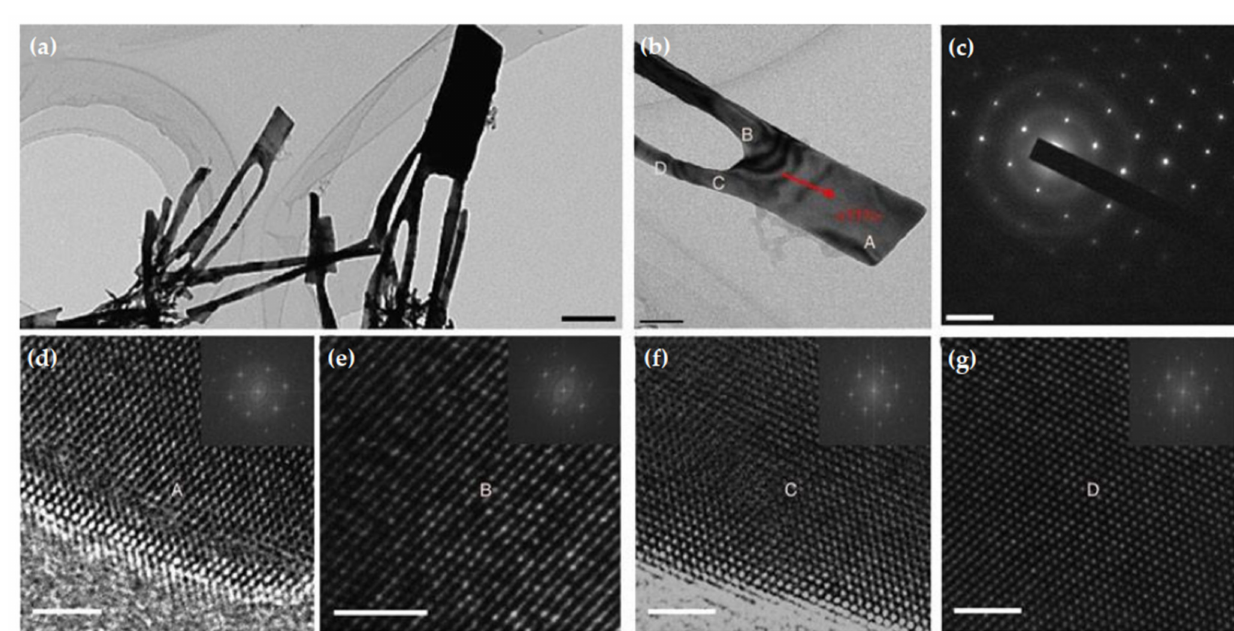
Figure 8. TEM analysis of Au nanostructures: ( a , b ) Topography images of prepared Au nanostructures. Scale bars, 200 and 50 nm, respectively. ( c ) Diffraction pattern of the Au hierarchical nanostructure in ( b ) showing a face-centered cubic single crystal structure and the axis of the nanostructure is determined along <111> crystallographic orientation. Scale bar, 5 nm − 1 . ( d – g ) High-resolution TEM images at the regions denoted by A, B, C, and D in ( b ) and fast Fourier transformations (insets) confirming the perfect single crystal of the Au hierarchical nanostructure. Scale bars, 2 nm. Adapted from [106], under the terms of the Creative Commons CC BY